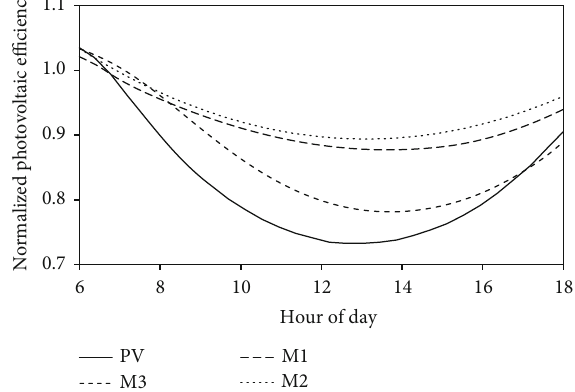
Figure 2: Daily dynamics of normalized photovoltaic e ffi ciencies (21 June